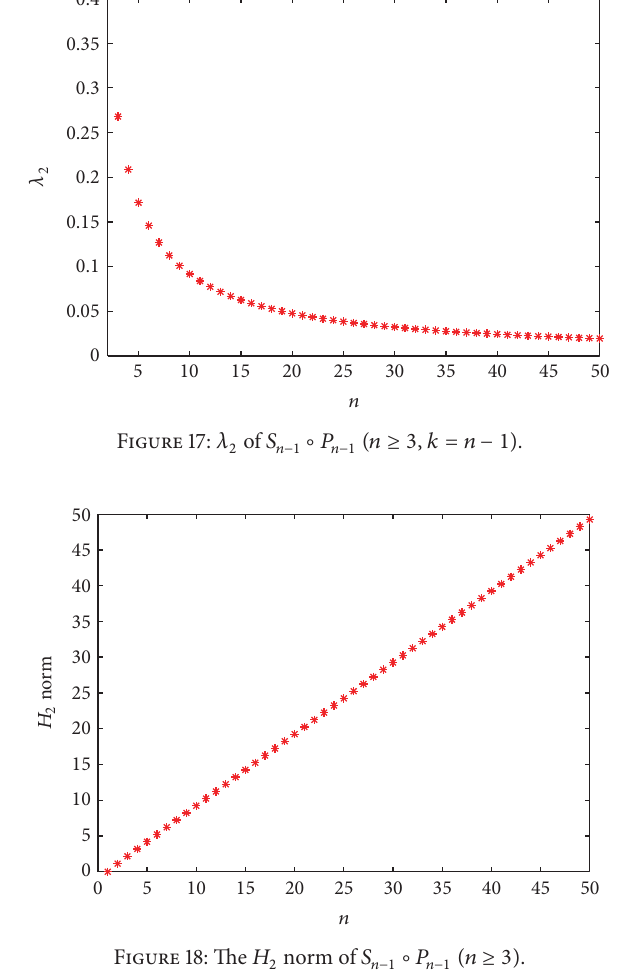
Figure 18: The 𝐻 2 norm of 𝑆 𝑛−1 ∘ 𝑃 𝑛−1 ( 𝑛 ≥ 3 ).